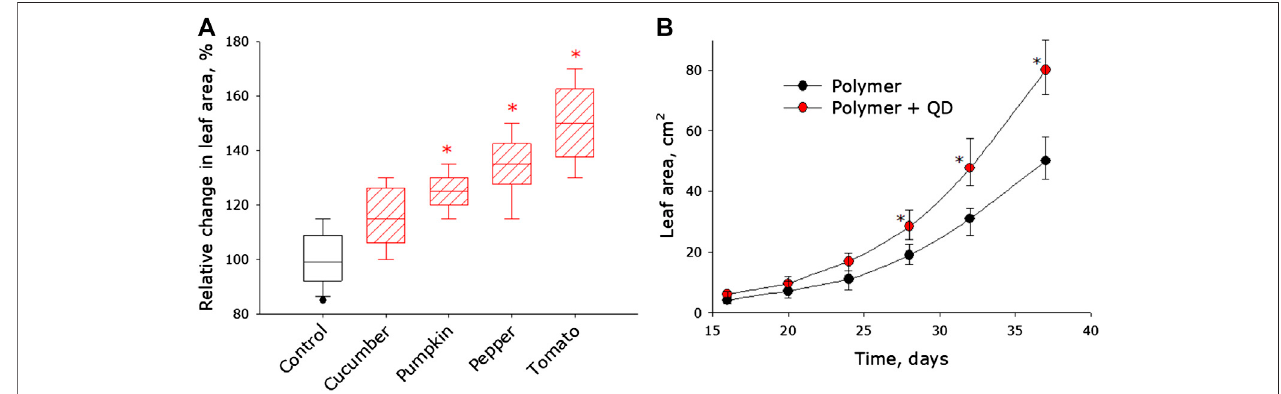
FIGURE3| Effectofphotoconversion fl uoropolymer fi lmonthegrowthanddevelopmentofplantsofvariousspecies. (A) Effectofphotoconversionpolymer fi lmon the size of leaves of cucumber ( Cucumis sativus ), pumpkin ( Cucurbita pepo ), pepper ( Capsicum annuum L ), tomato ( Solanum lycopersicum ). presented for all plants, the differences were calculated by groups. Other reference values are normalized. Data are presented as median with 95% con fi dence interval (box). The range is shown in the form of a whiskers. Statistically signi fi cant differences between s ontrol group and QD groups (Mann-Whitney U test, p < 0.05) are marked by asterisks. (B) Dynamics of changes in the leaf area of control tomato and tomato plants grown under a photoconversion polymer fi lm. Statistically signi fi cant differences between control group and QD groups (Mann-Whitney U test, p < 0.05) are marked by asterisks.